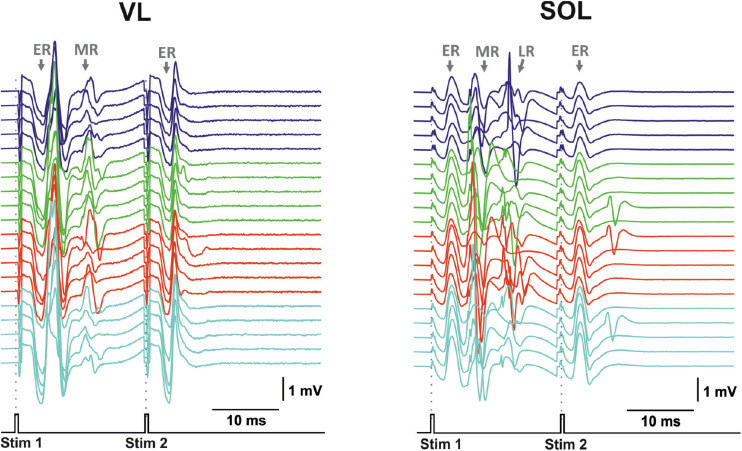
Examples of evoked potential dynamics with increasing current for transcutaneous double-pulse electrical stimulation (3,400–3,700 μA) delivered at the zone between VL2 and VL3 vertebra for mm. vastus longus (VL) and soleus (SOL). Stim, stimulation impulse; ER, early response; MR, medium response; LR, late response.